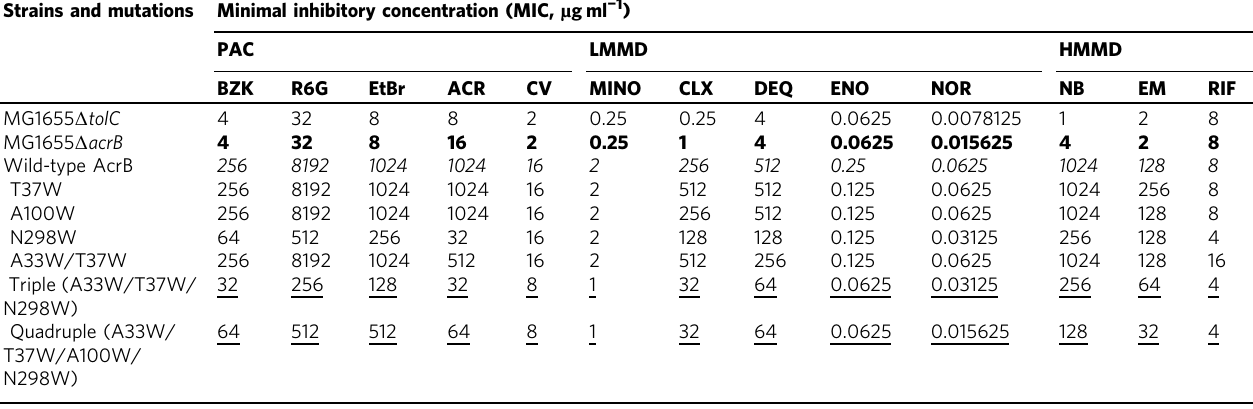
Table 1 MIC values for channel 3 (CH3) mutant AcrB-expressing E. coli MG1655 Δ acrB cells Strains and mutations Minimal inhibitory concentration (MIC, µ g ml − 1